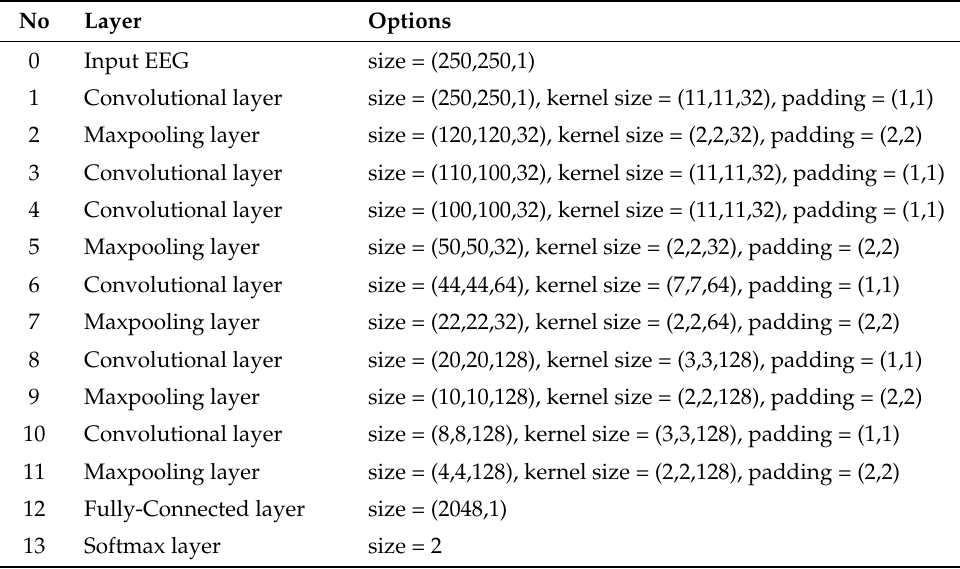
Table 1. Details of the network structure.